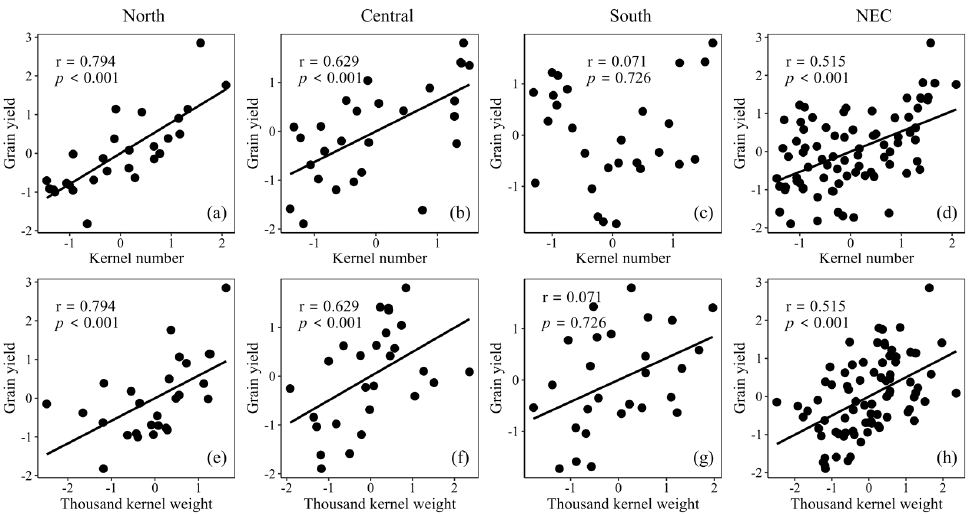
Figure 4. Relationship between grain yield and kernel number ( a – d ) and 1000-kernel weight ( e – h ). North: Keshan station; Central: Gongzhuling station; South: Shenyang station; NEC: Northeast China Plain; r: correlation coefficient.